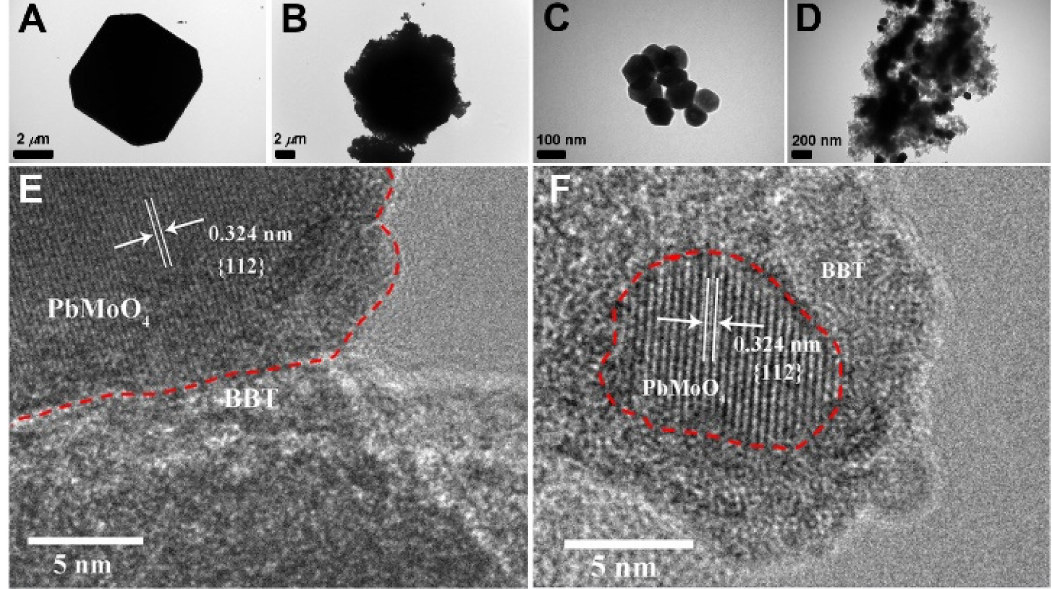
Figure 5. TEM images of ( A ) PMO(M), ( B ) 13.3% BBT-PMO(M), ( C ) PMO(N), and ( D ) 16.7% BBT-PMO(N). HRTEM images of ( E ) 13.3% BBT-PMO(M), and ( F ) 16.7%